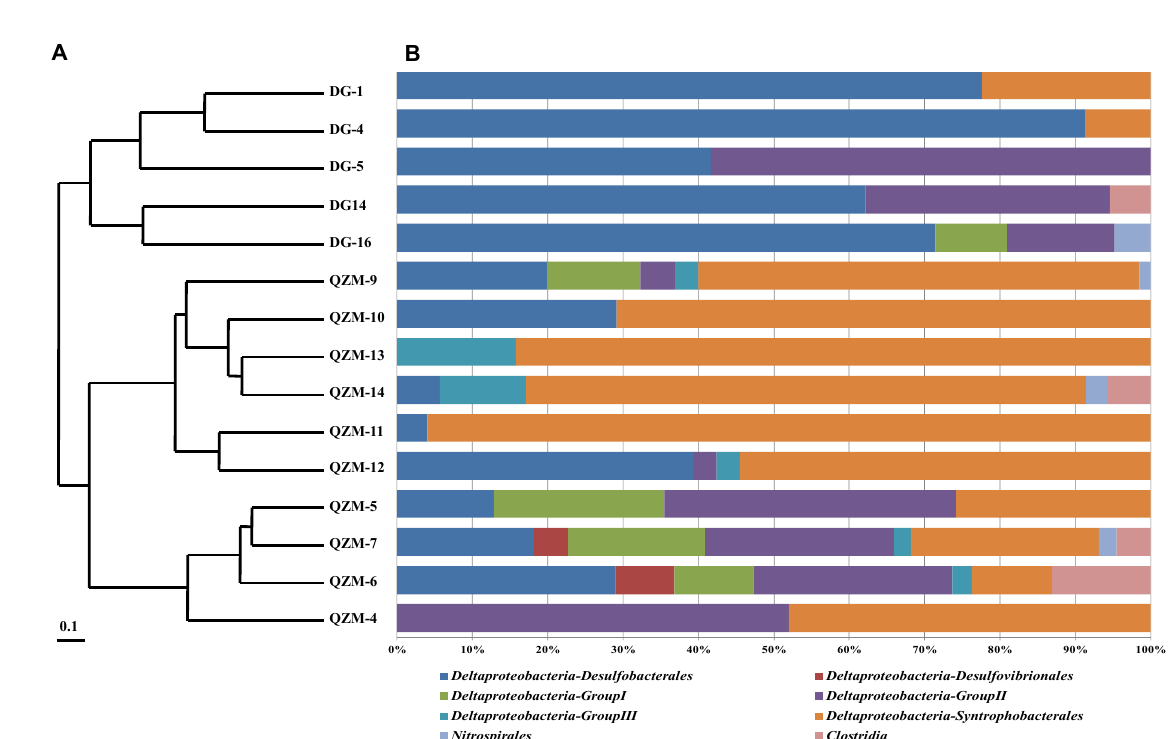
Figure 2. Cluster analysis of the drsB gene population composition in the investigated hot spring sediments based on Bray–Curtis dissimilarity. The topology was constructed with the pair group algorithm using the PAST software package ( A ). ( B ) represents community structures, showing the frequencies of clones affiliated with major phyla.